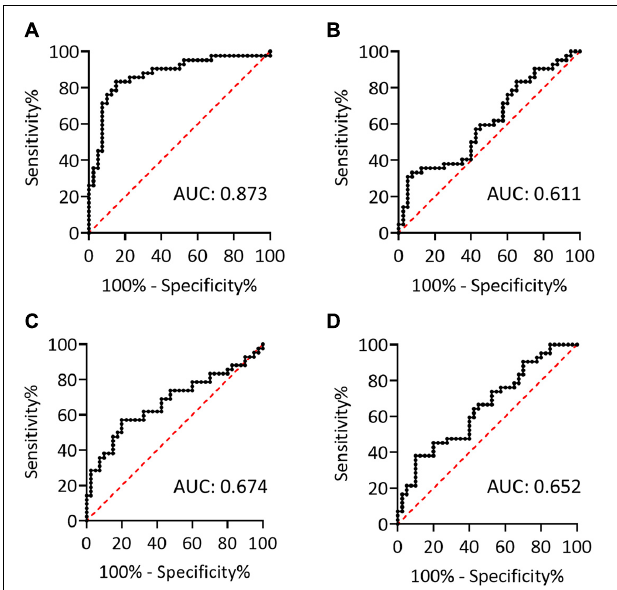
FIGURE 6 | Levels of α -synuclein and NFL in the plasma of patients with PD at early or advanced stages, and HCs. (A,B) Plasma levels of α -synuclein in patients with early ( n = 24) and advanced PD ( n = 18), and HCs ( n = 40) in K 2 -EDTA tubes centrifuged at (A) RT or (B) 4 ◦ C. (C,D) Plasma levels of NFL in patients with early and advanced PD, and HCs in K 2 -EDTA tubes centrifuged at (C) RT or (D) 4 ◦ C. Error bars represent SD . Comparisons by Kruskal-Wallis test followed by Dunn post hoc